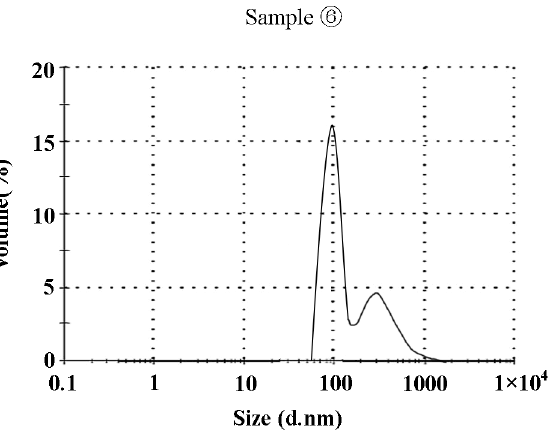
Figure 7. The particle size distribution of the system when the molar ratio of epoxy groups is E51:ED = 1:1.5.